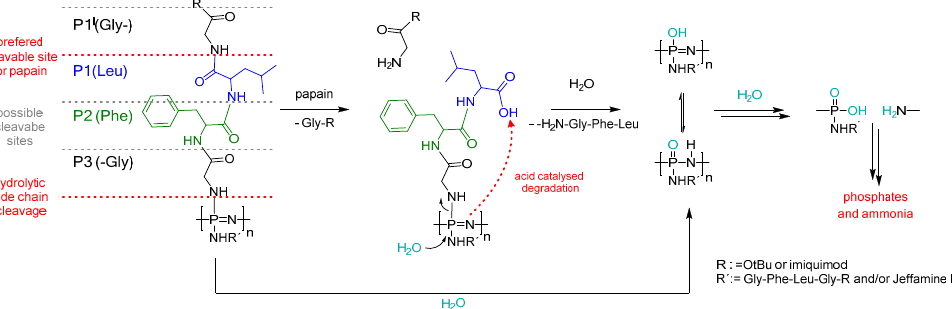
Figure 9. Preferential cleavable site of papain and proposed hydrolytic and enzyme initiated degradation mechanism of GFLG-peptide based poly(organo)phosphazenes.